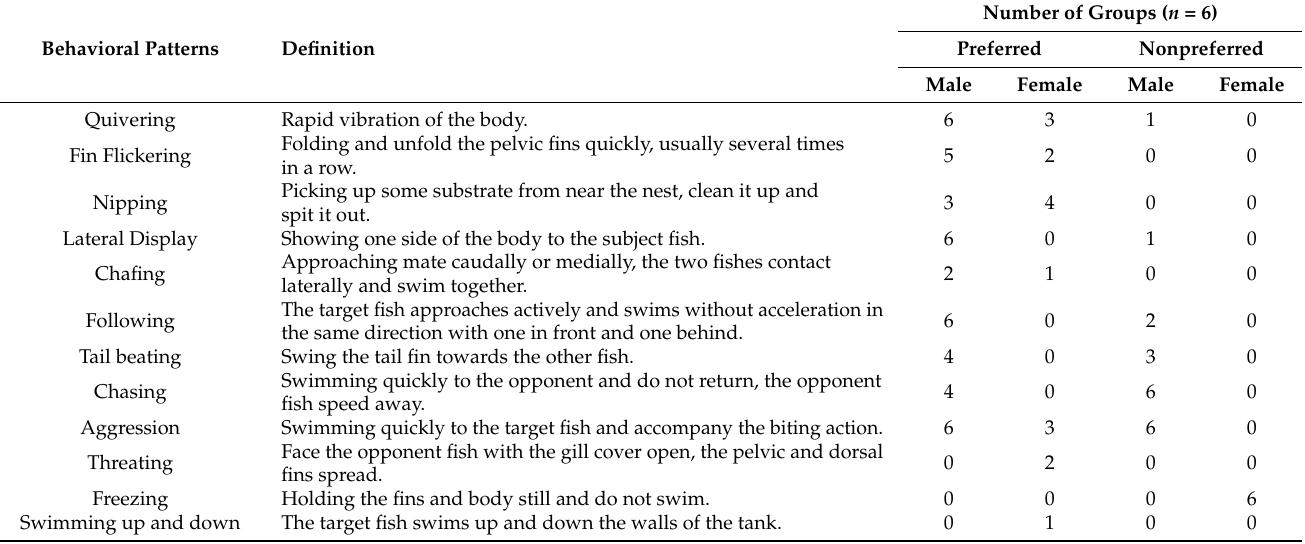
Table 1. Behavioral patterns of males and their preferred and non-preferred